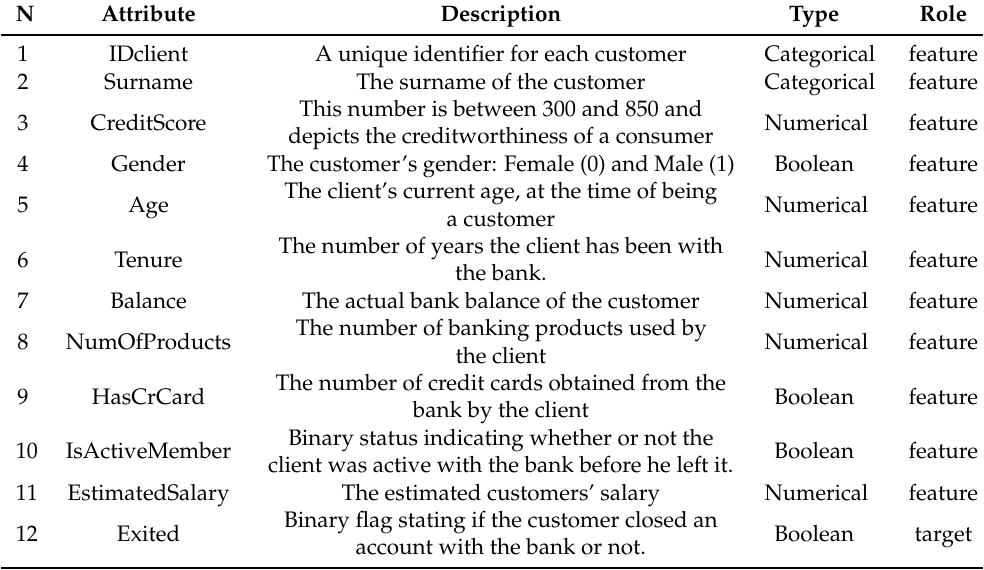
Table 2. Details of bank churn